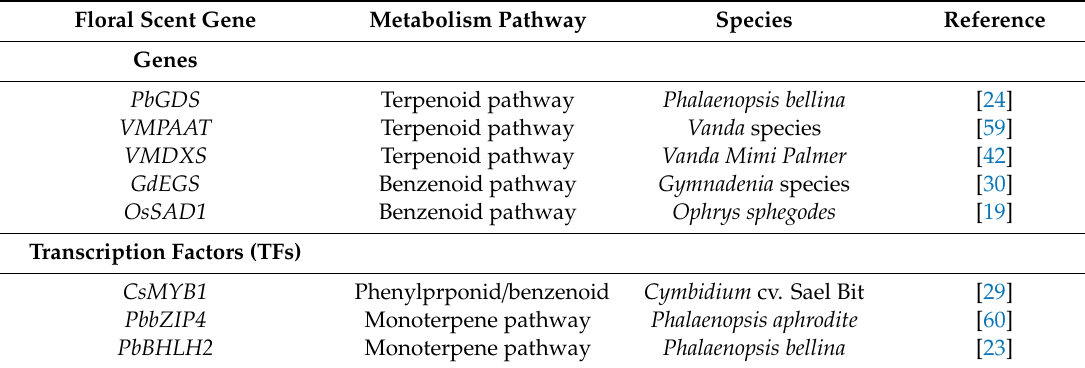
Table 2. Representative genes responsible for floral scents in